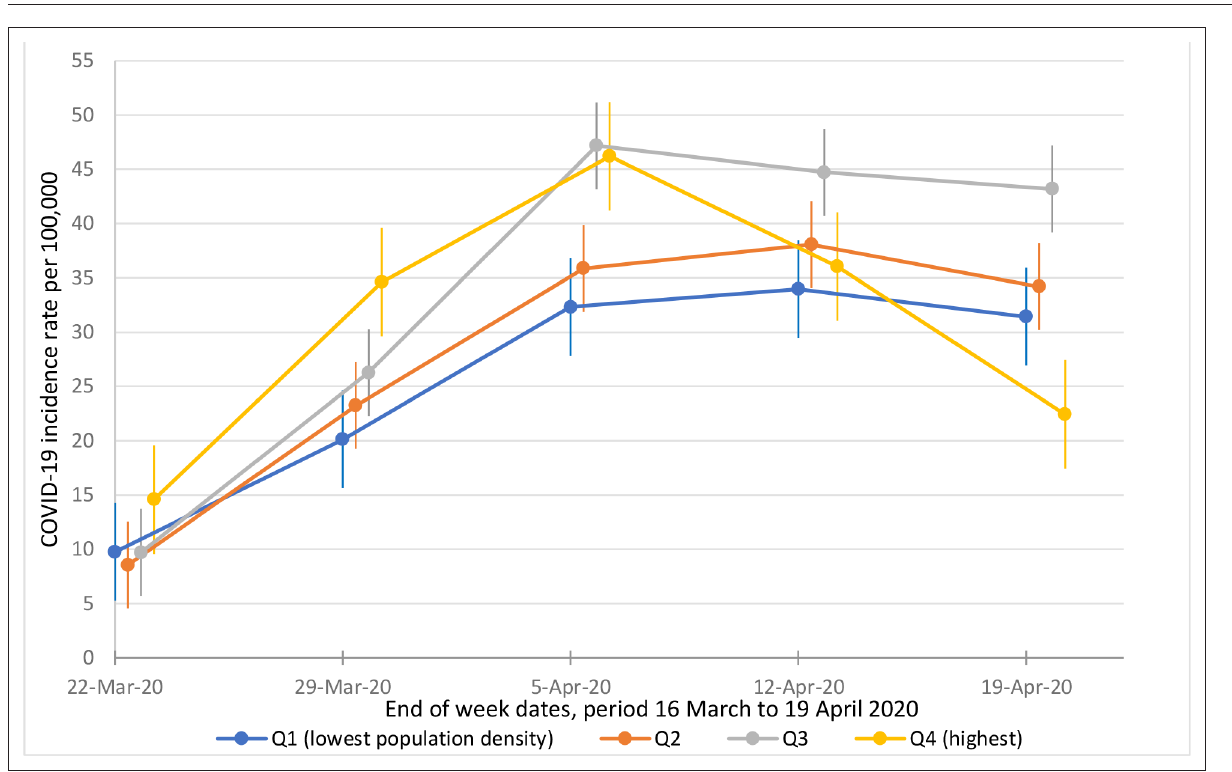
Figure 1 Estimates of B- coefficients (95% CI) from multilevel regression model for the association between population density and weekly regional Note: regression adjusted for percentage of population non- white British, percentage of population in two highest classes of the National Statistics Socioeconomic Classification, male life expectancy at birth, percentage aged ≥65 years, and COVID-19 prevalence rate per 100 000 people on March 15 ; covariates were standardised around the mean. 95% CI = 95% confidence interval; Q1= quartile 1 (lowest population density); Q4= quartile 4 (highest population